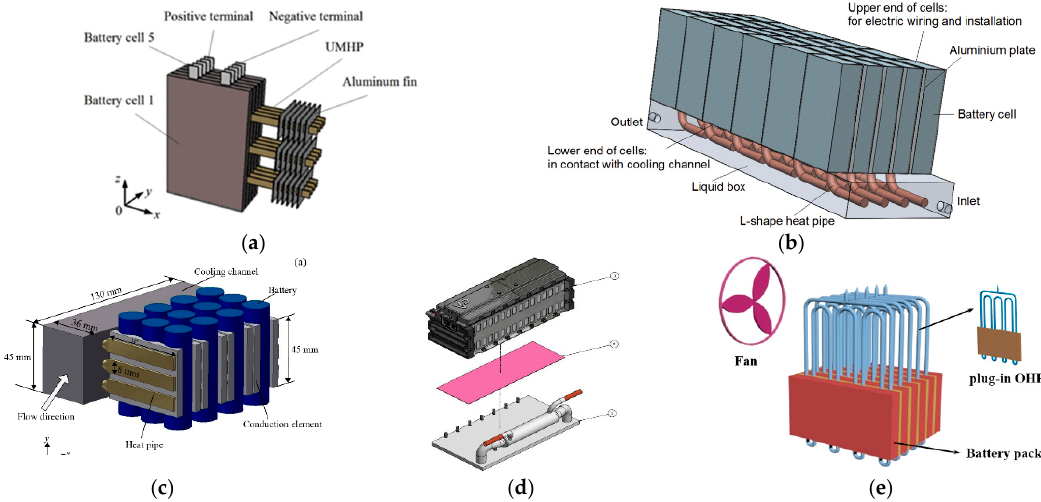
Figure 4. Examples for HP-based hybrid BTMS coupled with active cooling methods. ( a ) Hybrid BTMS with an ultra-thin micro heat pipe, Reprint with permission [48]; 2020, Elsevier., ( b ) HP-based BTMS associated with liquid cooling, Reprint with permission [56]; 2020, Elsevier., ( c ) A HP-based BTMS with cylindrical battery cells, Reprint with permission [52]; 2020, Elsevier., ( d ) Battery module is set above the heat mat [3], ( e ) Plug-in oscillating heat pipes (OHPs) are sandwiched by battery packs. Reprint with permission [54]; 2020, Elsevier.